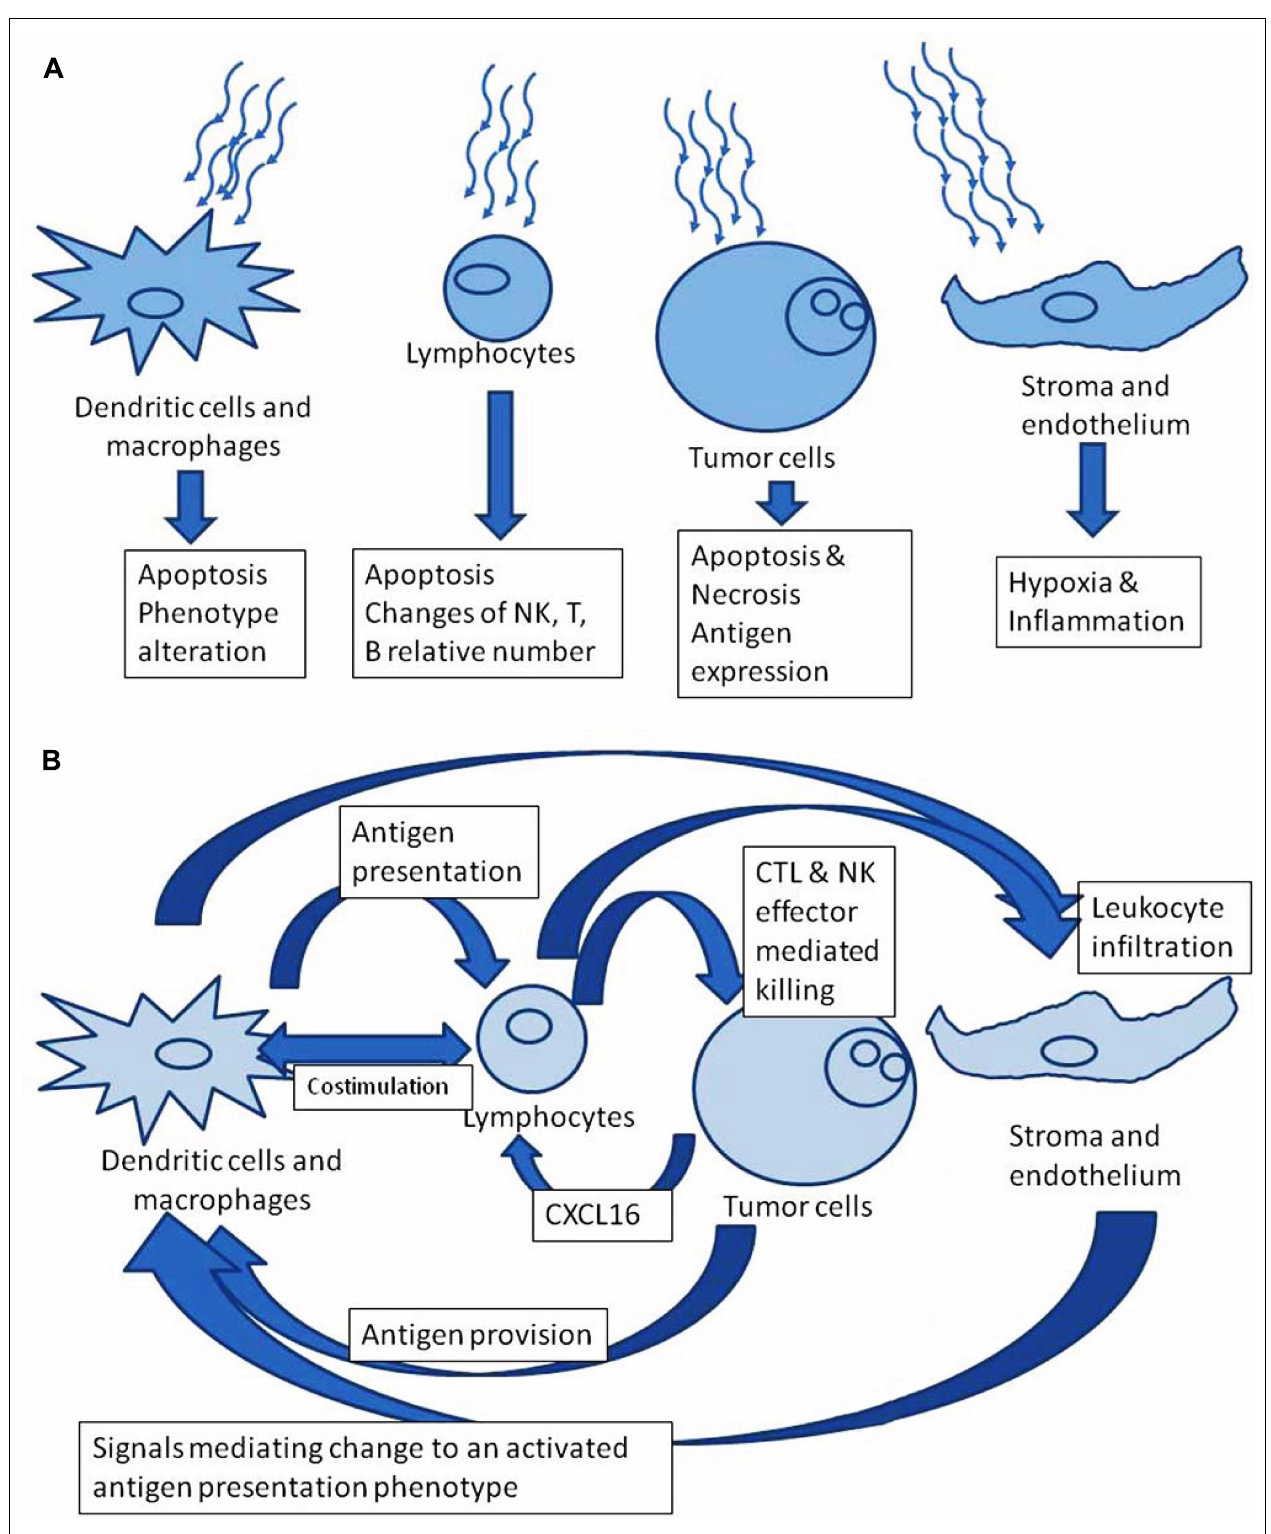
FIGURE 1 | (A) Radiation effects in isolation. (B) Downstream theoretically favorable immune modulation after irradiation.